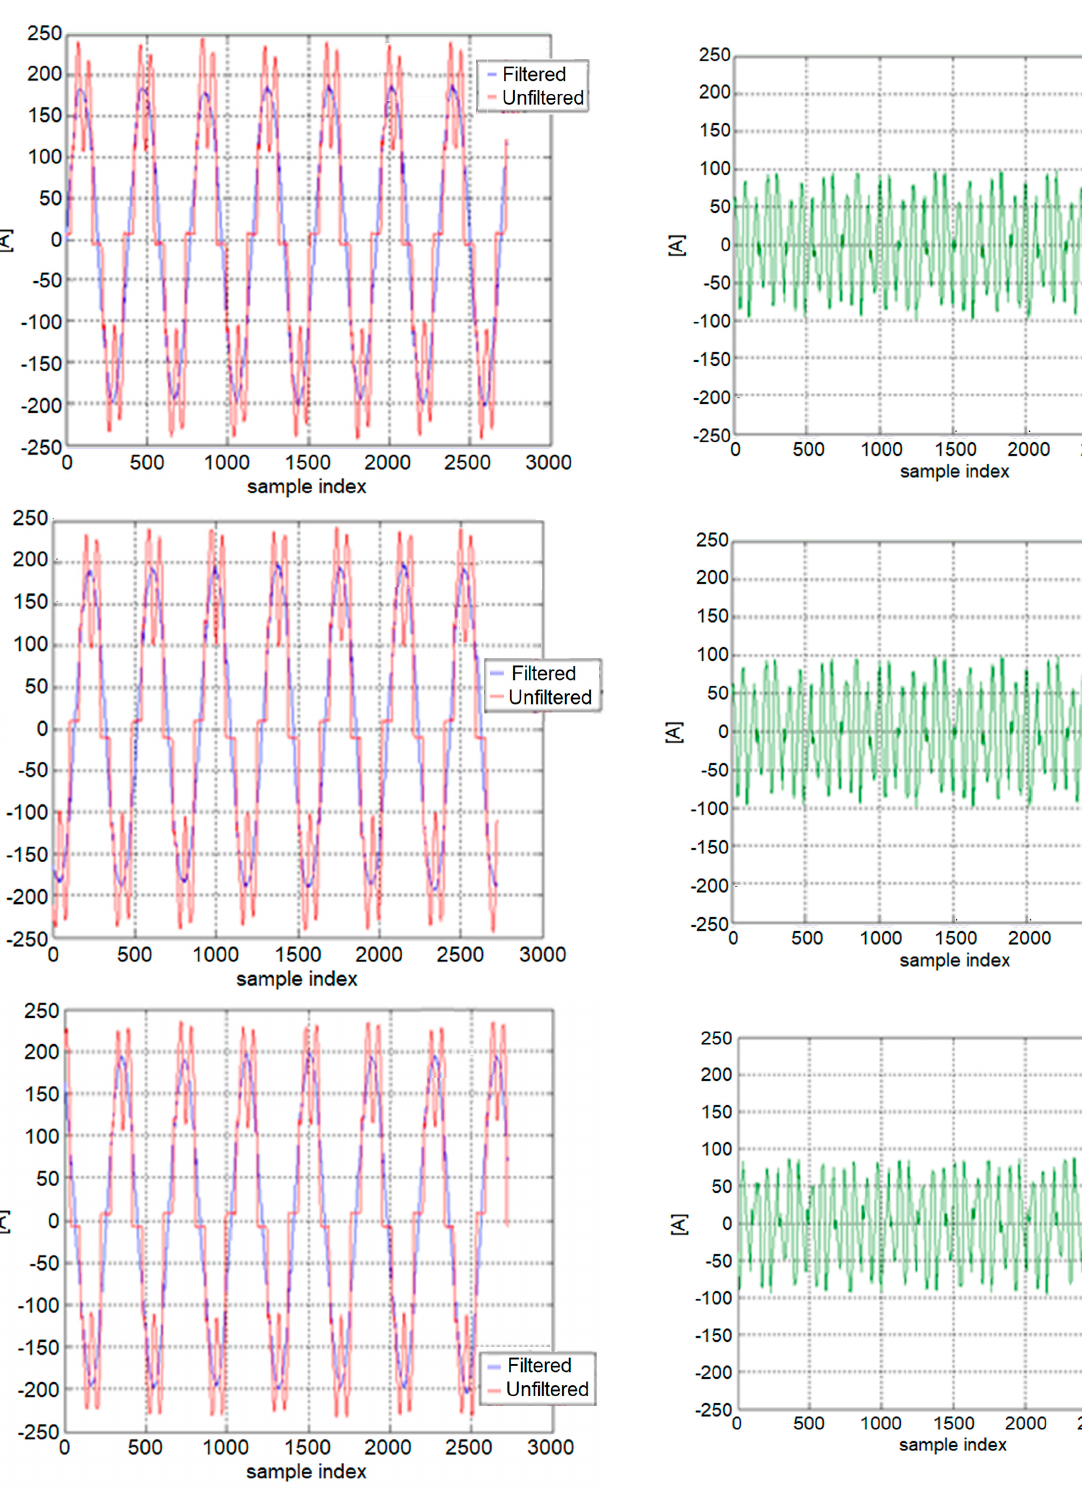
Figure 17. Case γ (RMS of phase currents equal to 142 A). ( Left ) Unfiltered phase currents (red) overlapped with filtered currents (blue). ( Right ) Difference between filtered and unfiltered currents.